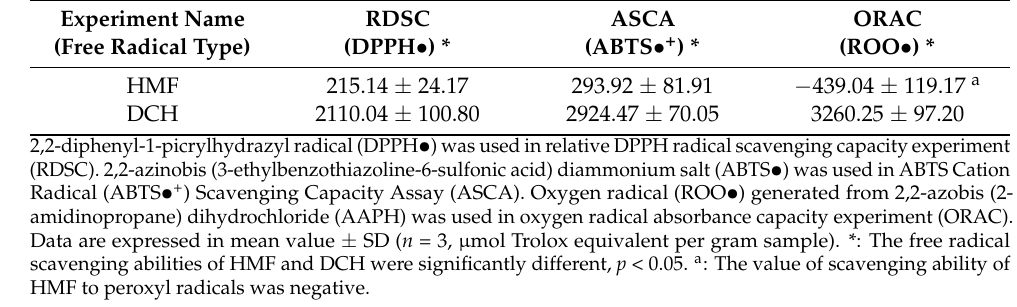
Table 2. Results of free radical scavenging